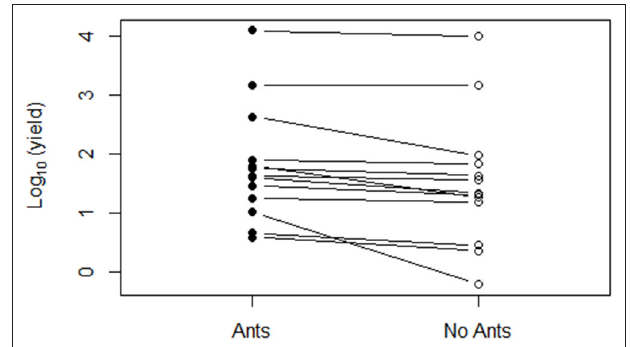
FIGURE 1 | Measurements of the influence of Oecophylla spp. as biological control agents on crop yields (log-transformed) for cacao, cashew, citrus, coconut palm, and mango trees were compiled from 11 studies. Lines compare treatments for each study, indicating how yields increased under ant treatments compared to yields from trees without ants (Vanderplank, 1960; Sporleder and Rapp, 1998; Peng et al., 1999; Ayenor et al., 2007; Dwomoh et al., 2009; Bharti and Silla, 2011; Abdulla et al., 2015, 2017; Anato et al., 2015, 2017; Bisseleua et al.,